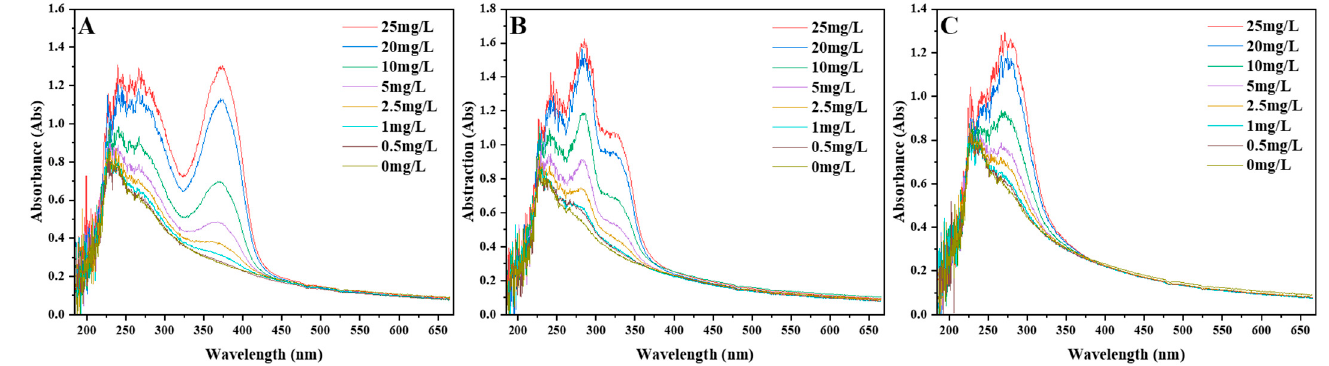
Figure 4. Absorption spectra of ( A ) tetracycline, ( B ) ofloxacin, and ( C ) chloramphenicol diluted to different concentrations with wastewater.